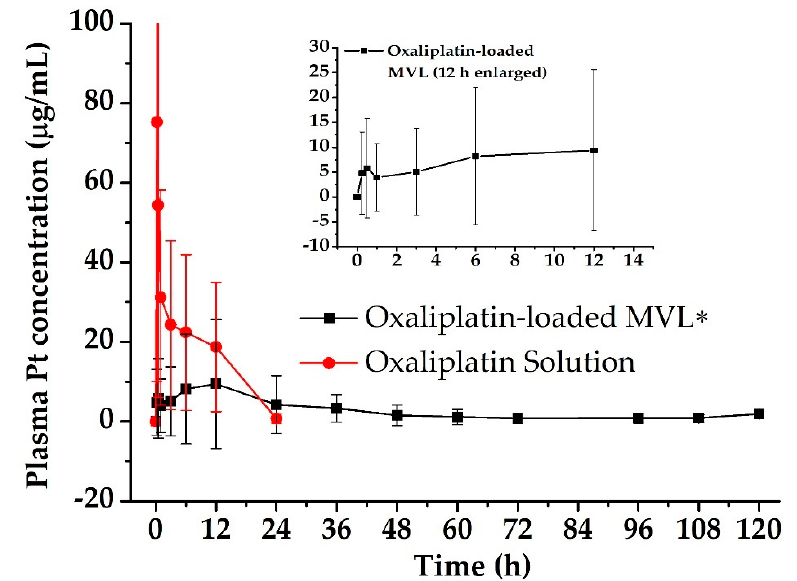
Figure 6. Plasma concentration-time profile of platinum (Pt) in rats after the early postoperative intraperitoneal chemotherapy (EPIC) regimen of the oxaliplatin solution and oxaliplatin-loaded liposomal depots. Data are expressed as the mean ± standard deviation ( n = 5). * p < 0.05. Table 3. In vivo pharmacokinetic parameters after intraperitoneal administration to rats ( n = 5).